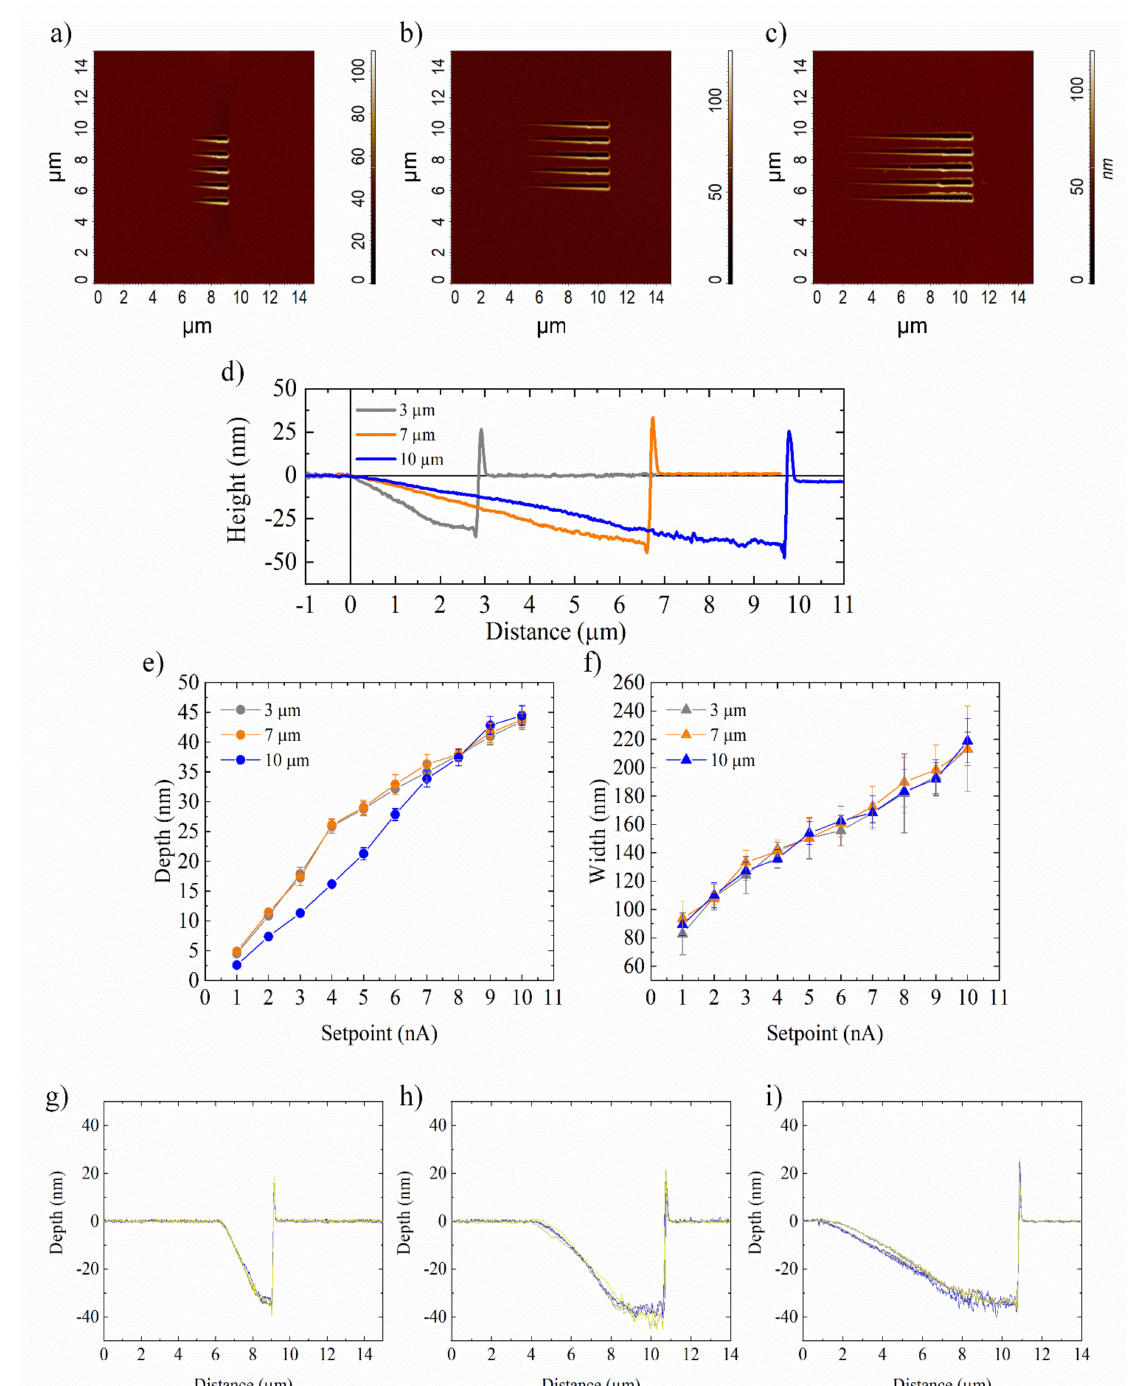
Figure 5. SensHeight AFM topography of nanochannels with a linearly variable depth profile, 3 ( a ), 7 ( b ), and 10 µ m ( c ) long. ( d ) Representative cross-section profile of nanochannels 3, 7, and 10 µ m long. ( e ) Mean depth and ( f ) width values in correspondence to different setpoint; each mean value was calculated for 20 points. ( g – i ) The superimposition of five different cross-section curves for nanochannels 3 ( g ), 7 ( h ), and 10 µ m ( i ) long. The data reported in ( e , f ) were statistically significant for p <